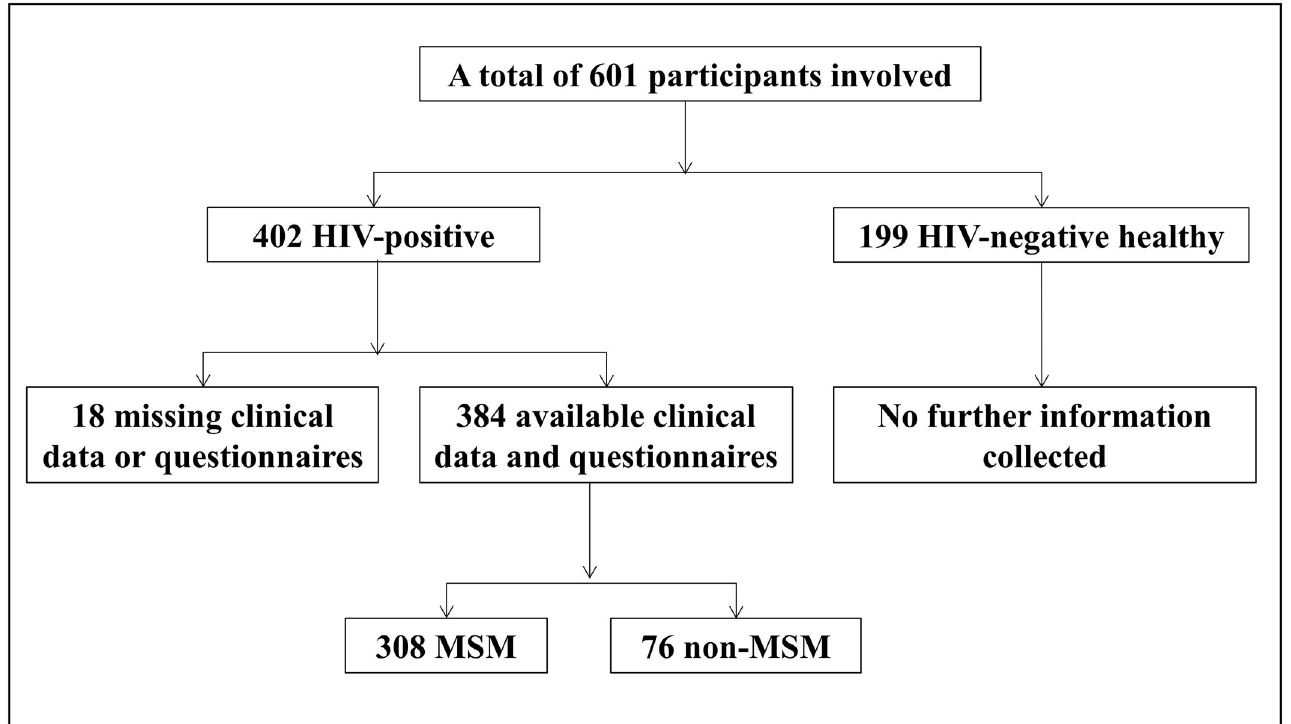
Fig 2. Number of study participants at various stages of recruitment.